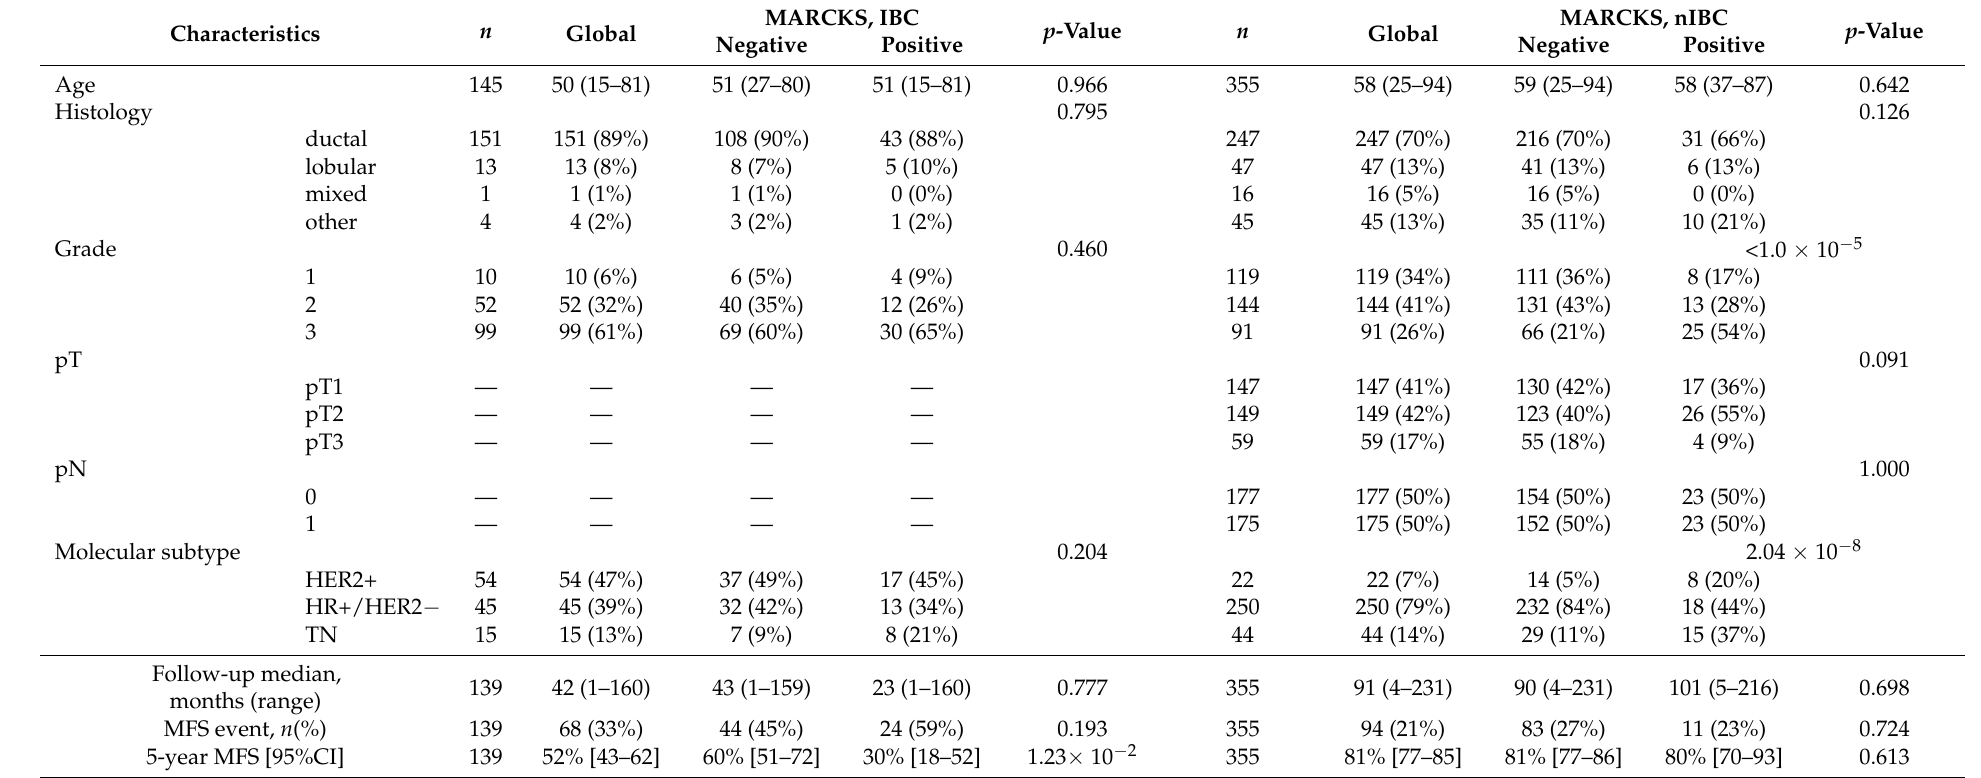
Table 1. Correlations of MARCKS expression with clinicopathological variables in 180 IBC and 355